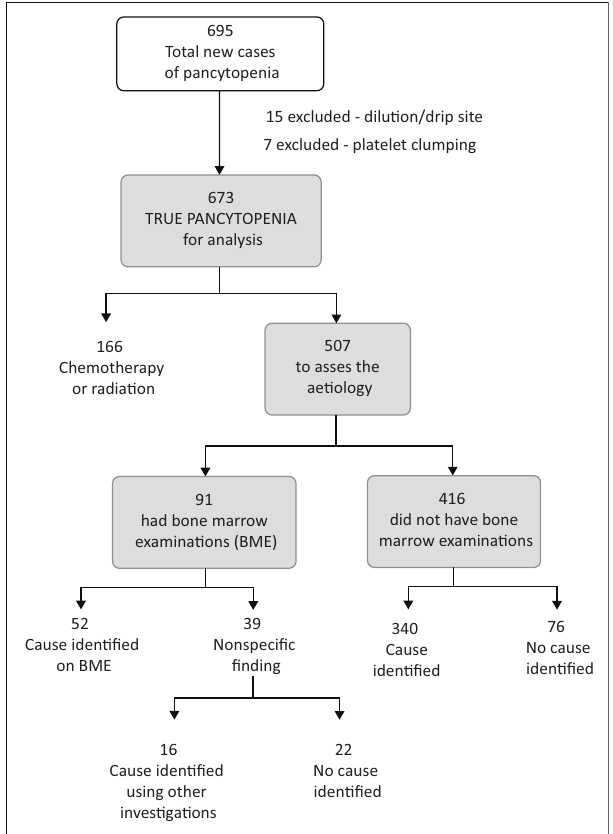
FIGURE 1: Flow diagram of case selection and stratification to identify the causes of pancytopenia at Tygerberg Academic Hospital, Cape Town, South Africa, from January 2016 to December 2017.